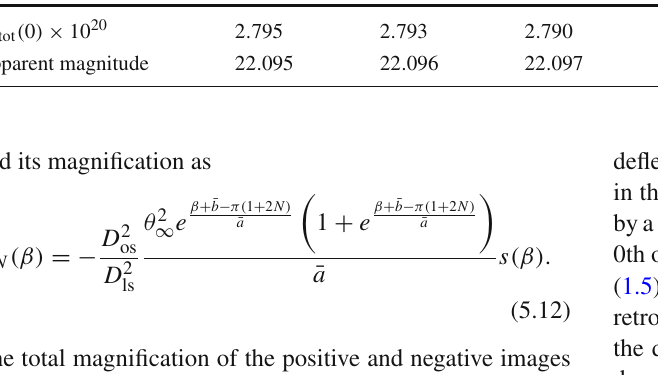
Table 4 Retro lensing with deflection angle (1.1): We have assumed the same parameters as Table 3 Q /